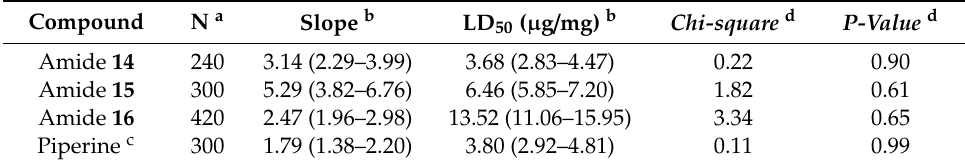
Table 1. Dose-mortality curves of the most e ffi cacious amides and piperine (positive control) to second instar larvae of Tuta absoluta 48 hours after topical